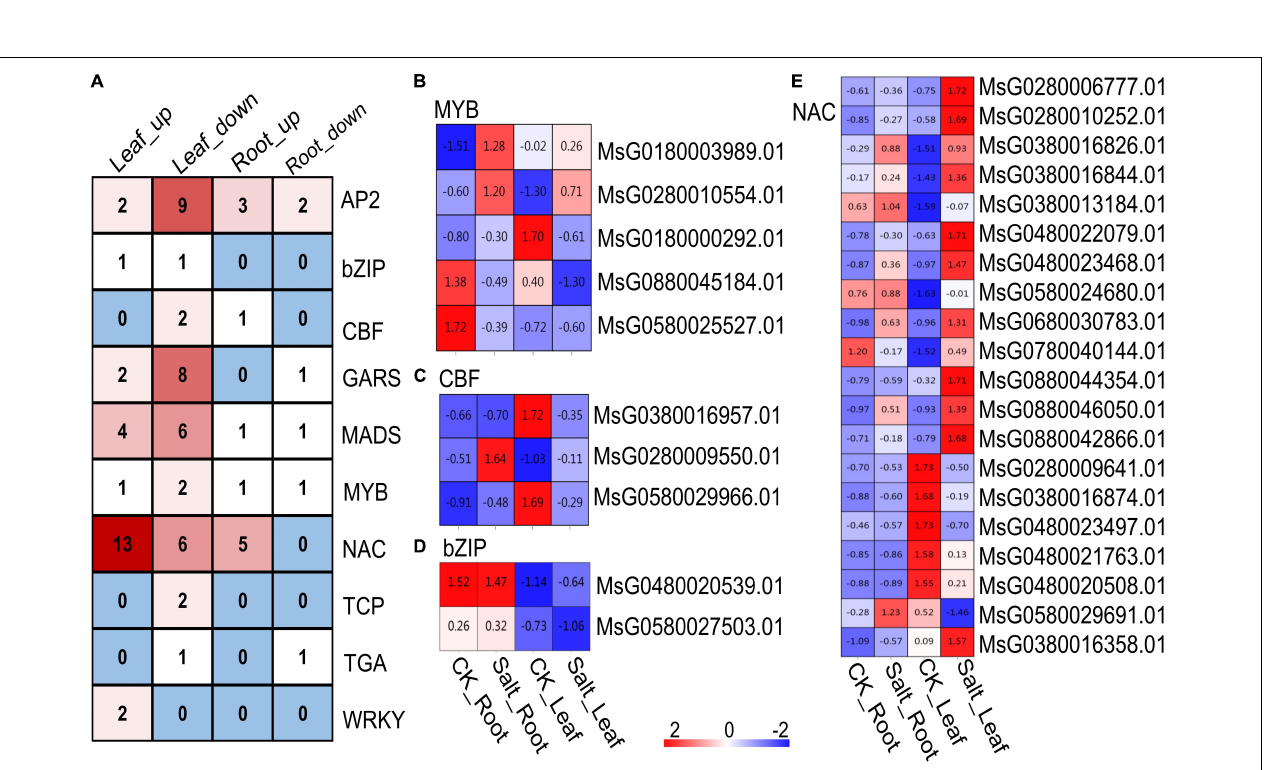
FIGURE 4 | Transcriptome analysis of differentially expressed TFs. (A) Number of differentially expressed TFs. (B) Differentially expressed MYB-encoding genes. (C) Differentially expressed CBF-encoding genes. (D) Differentially expressed bZIP-encoding genes. (E) Differentially expressed NAC-encoding genes. The color in each cell in panel (B–D) indicates the value of expression